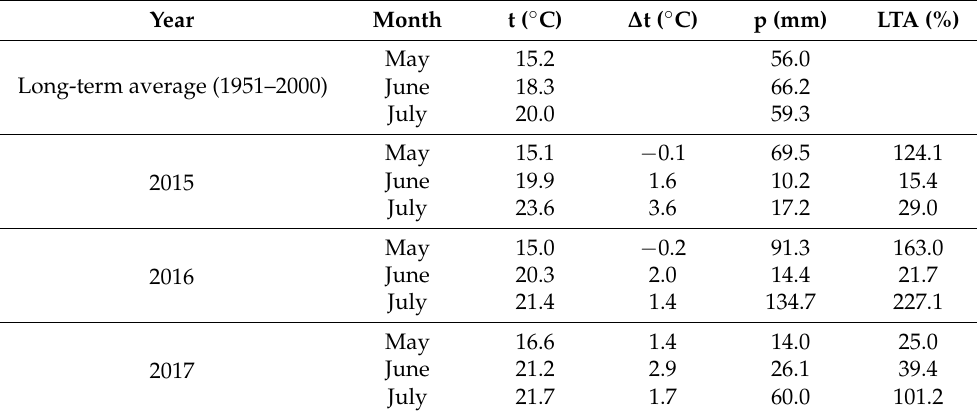
Table 1. Meteorological data during maturation